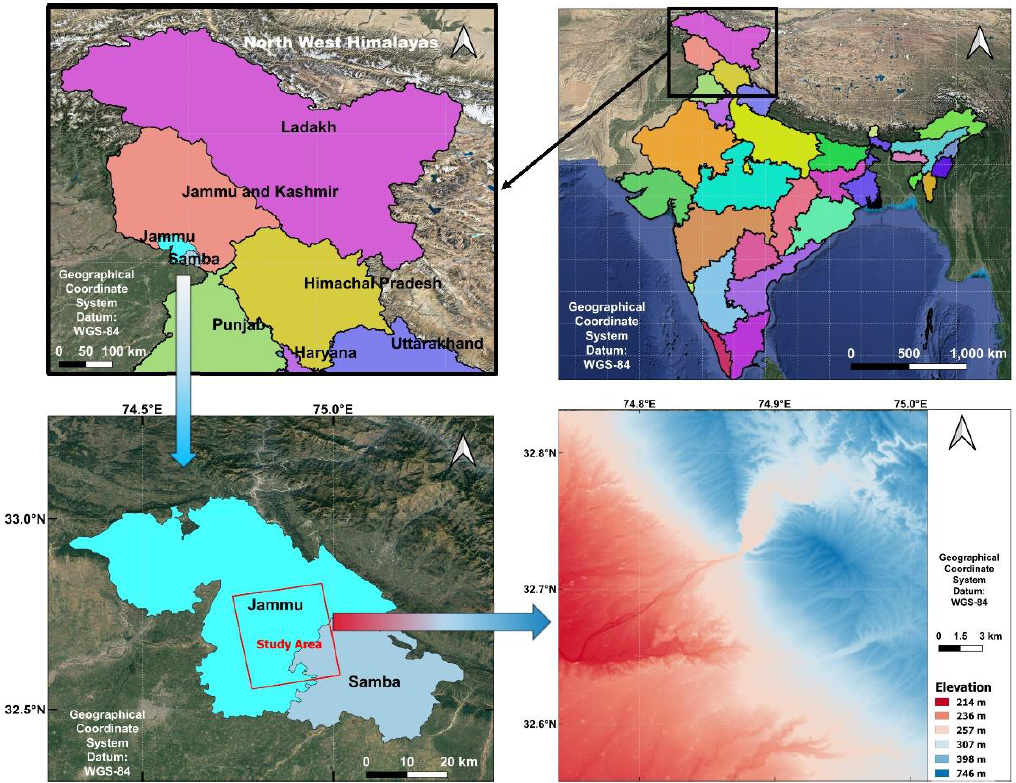
Figure 1. Study area in Jammu district. A map of India and the north-west Himalayas is shown with the different states and UTs connected with Jammu and Kashmir, and a zoomed view of the study area covering Jammu city and some regions of Samba district. The Copernicus 30 m DEM is shown to illustrate the topography of the study area.